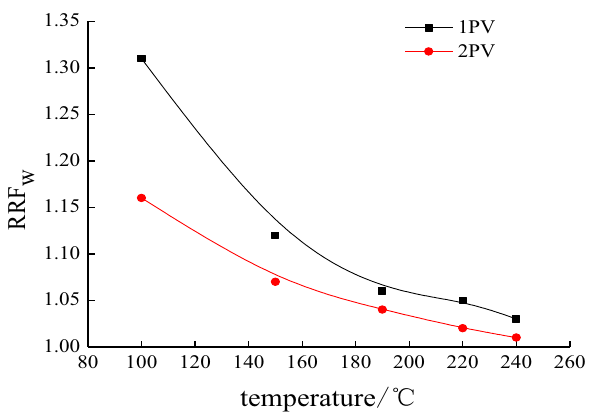
Fig. 6 Relationship between temperature and RRF PVs